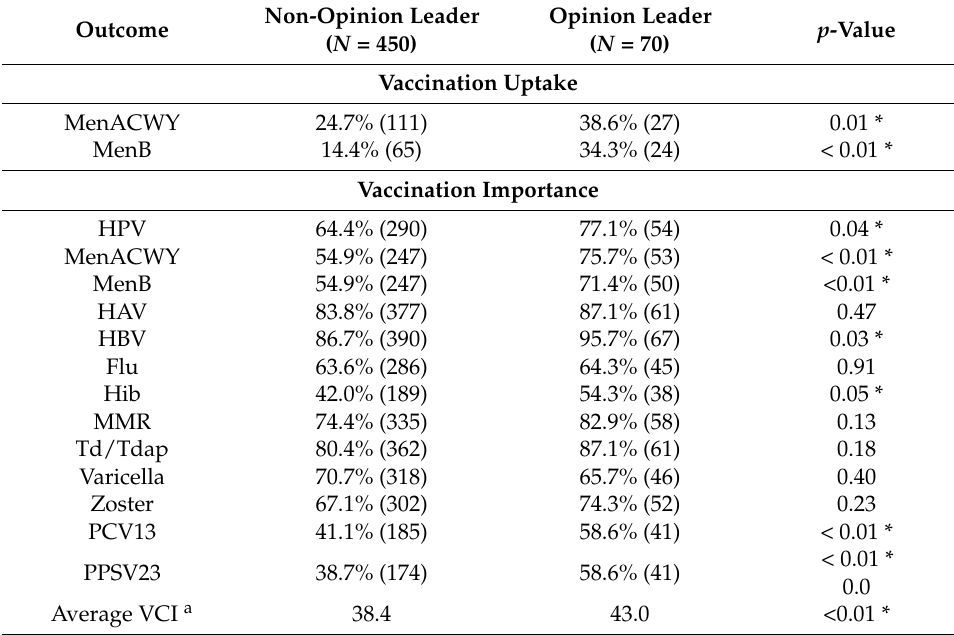
Table 2. Percentages of opinion leadership (yes vs. no) by vaccine uptake and importance. Outcome